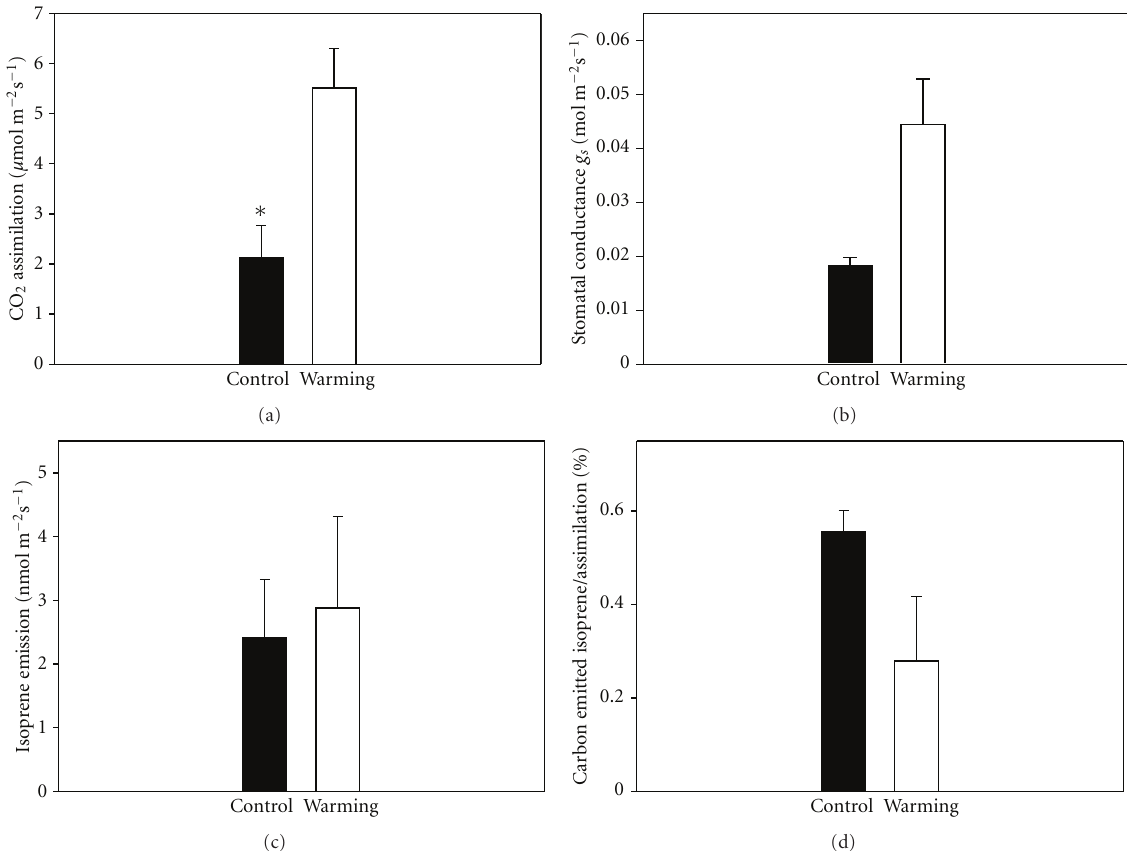
Figure 5: Time course of (a) CO 2 Assimilation ( μ molm − 2 s − 1 ), (b) Stomatal conductance (molm − 2 s − 1 ), (c) Isoprene emission (nmolm − 2 s − 1 ), (d) percentage of assimilated carbon lost as isoprene (%), ± S.E. for Salix phylicifolia grown close to the hot-spring (warming) and far away the hot water (control). ∗ P ≤ 0 . 05, ∗∗ P ≤ 0 . 01, ∗∗∗ P ≤ 0 .